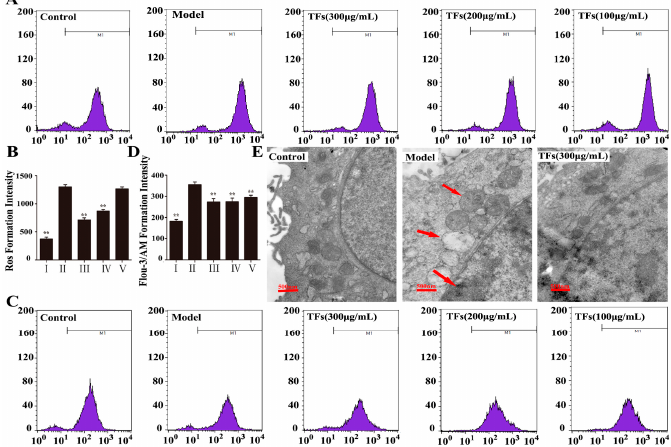
Corrected Figure 2. ROS generation detected by flow cytometry ( A, B ); The level of Ca 2+ detected by flow cytometry ( C, D ); Protective effect of the TFs on the ultra-structure of PC12 cells (40,000×, final magnification) ( E ). Data are presented as mean ± SD ( n = 5). * p < 0.05 and ** p < 0.01 compared with model group. The arrows pointed cytoplasmic vacuoles, chromatin condensation and mitochondrial swelling of the cells treated by H 2 O 2 .